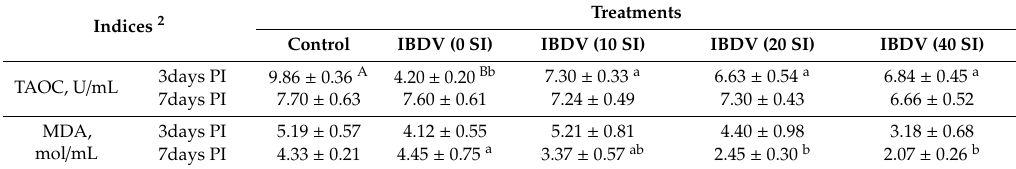
Table 8. E ff ect of adding soy isoflavones on serum antioxidant index of IBDV-challenged broilers 1 . Treatments Indices 2 Control IBDV (0 SI) IBDV (10 SI) IBDV (20 SI) IBDV (40 SI) TAOC, U /